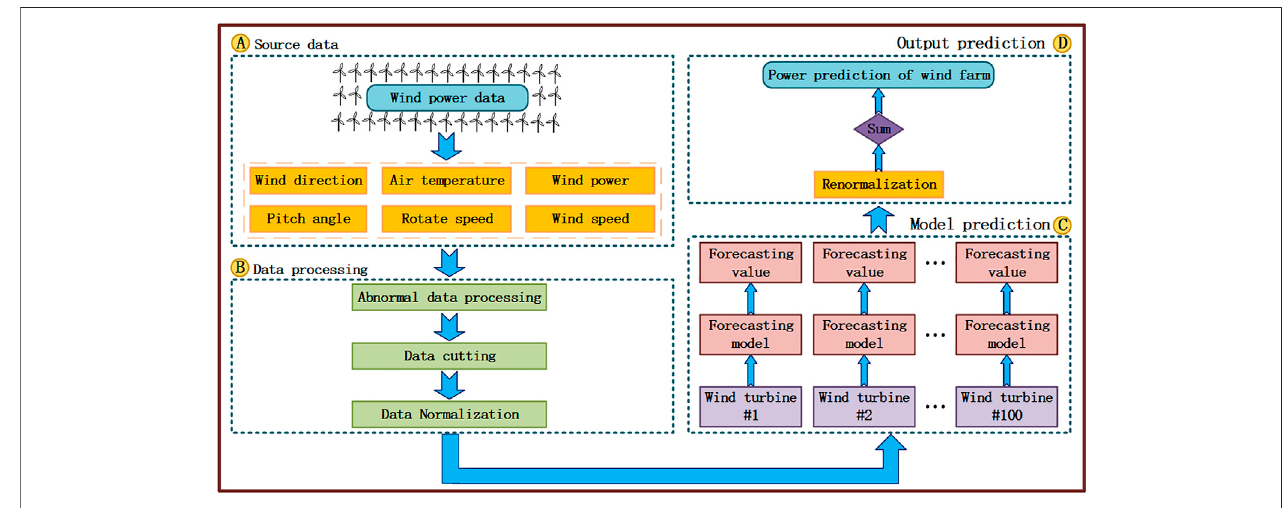
FIGURE 4 | Wind ultra-short-term-power prediction